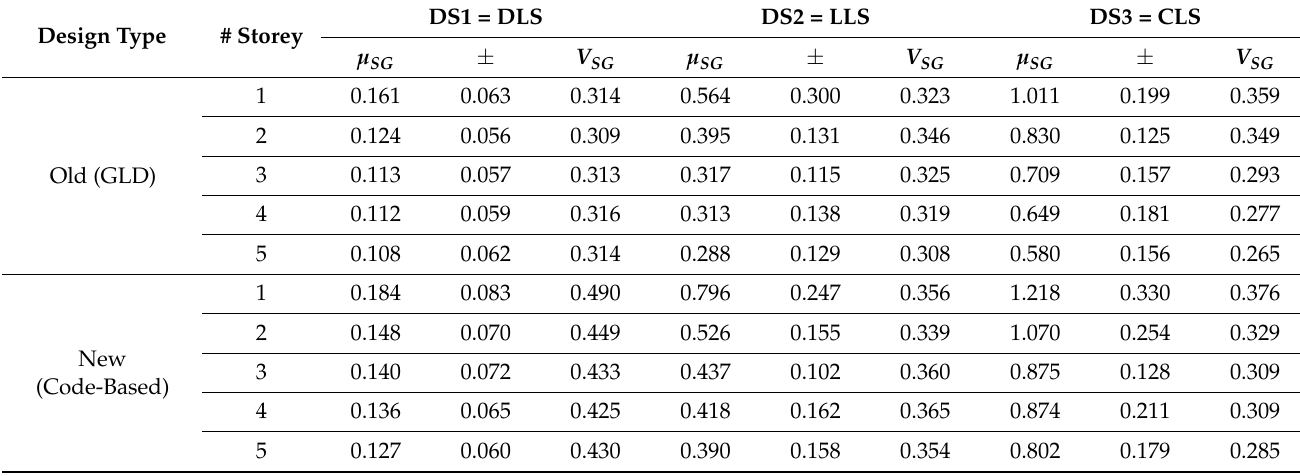
Table 6. Fragility curve parameters including soil type (mean µ SG , fuse width around the mean, and coefficient of variation V SG of the PGA-based capacity), for three Damage/Limit States, two construction types (“Old”, Gravity Load Design, and “New”, code-based design) and with number of storeys ranging from 1 to 5.